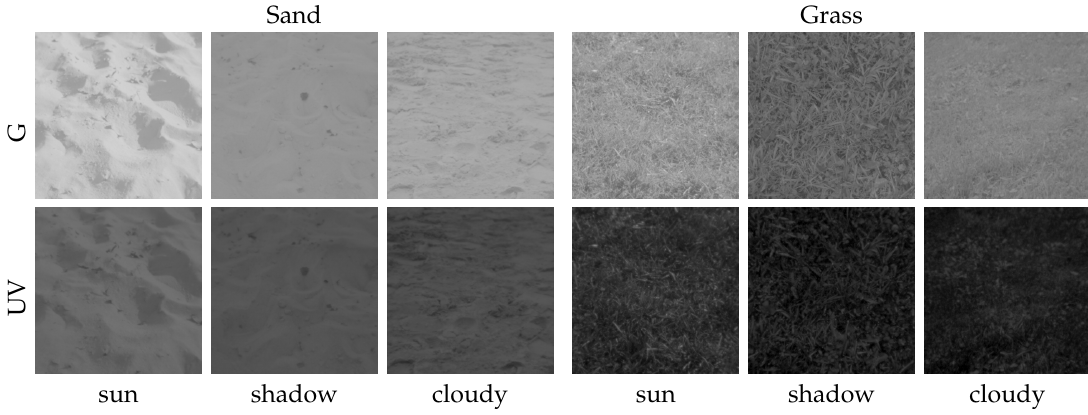
Figure 6. Single HDR images of sand and grass captured with our camera setup for both the UV and green channel. A total of three different images have been taken for each object: Two images were taken on a sunny day, one time where the object is exposed to the sun (sun) and one time lying in the shadows (shadow). A third one was collected during a cloudy day